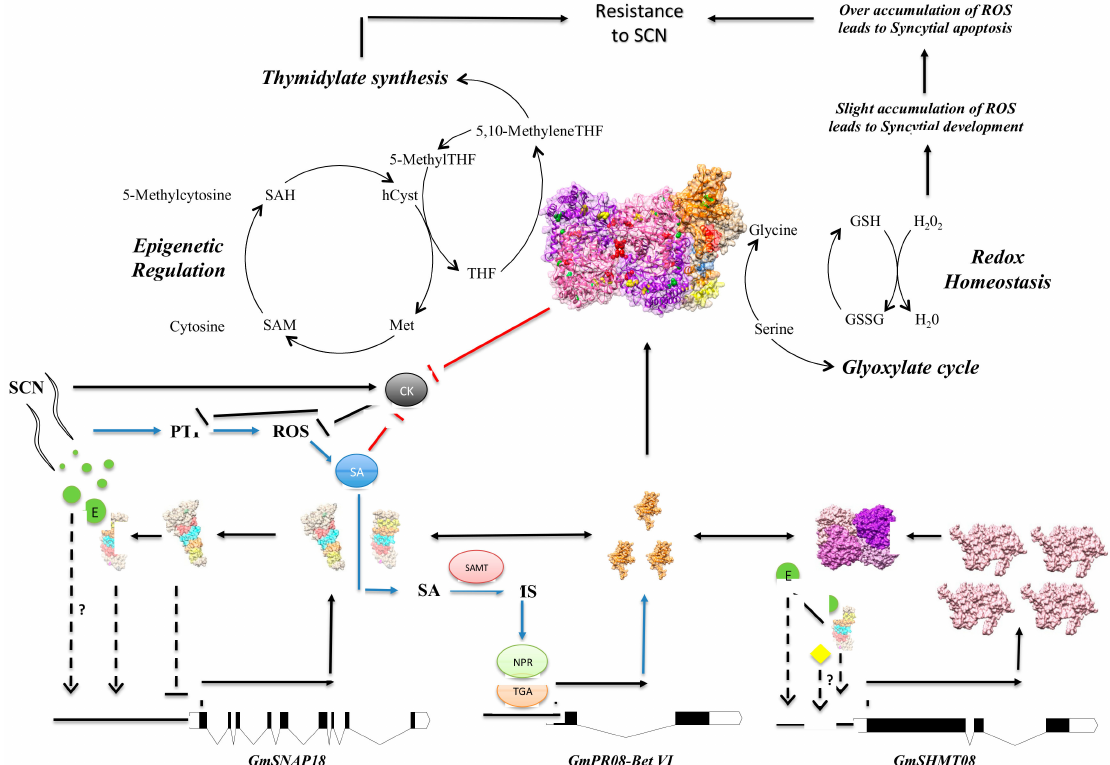
Figure 8. Deciphering SCN resistance mechanism in Peking-type. Cross-talk between SCN resistant genes, defense genes, and phytohormones is shown as described earlier (Lakhssassi et al., 2020). Dashed lines represent unknown possible intermediary steps. The possible binding of a nematode e ff ector (E) may interrupt the autoregulation of GmSNAP18, causing an increase in the transcription of GmSNAP18, consequently causing an induction of GmSHMT08. Next, the multi-protein complex may modulate the activity of the GmSHMT08 in single carbon metabolism, methionine synthesis, and maintenance of redox homeostasis within the root cells. Induction of the apoptosis, necrosis, and degeneration observed in the cells surrounding the syncytia may occur. Metabolite abbreviations are as follows—(SAH) S-adenosylhomocysteine; (SAM) S-adenosylmethionine; (hCyst) homocysteine; (Met) methionine; (THF) tetrahydrofolate; (GSH) reduced glutathione; (GSSG) oxidized